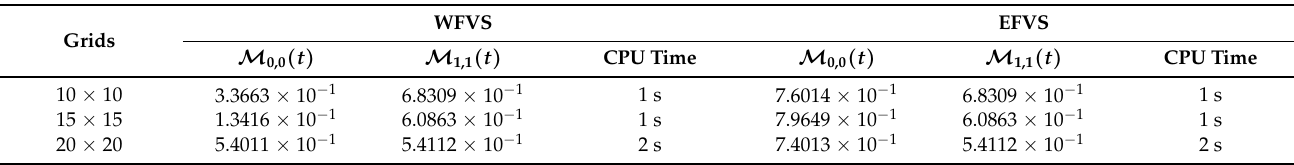
Table 11. Relative error for the weighted moments at different grid points for the test case with S = xy and breakage function b 4 at t = 10.